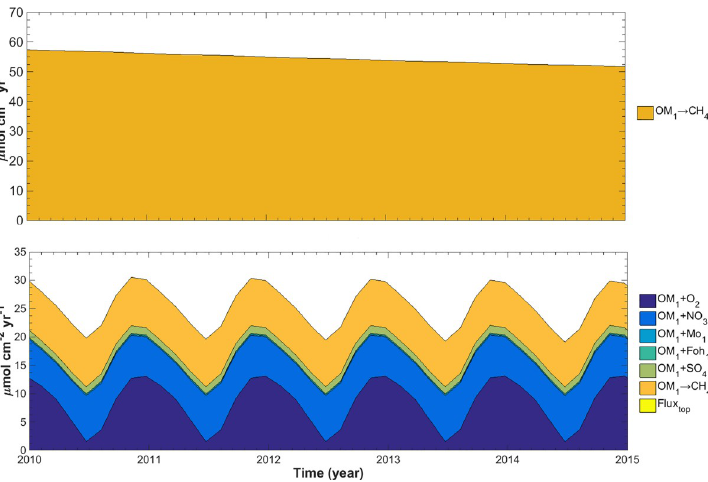
Fig 10. Production of CH 4 (top) and NH 4+ (bottom) for the seasonal SQ model from 2010 to 2015. The colors indicate the pathway of production.